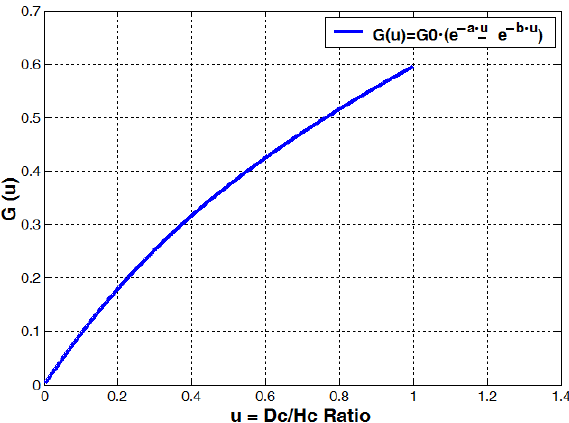
Figure 2. Coil geometry dimensionless function (factor) derived from the Lundin inductance formula and the Medhurst coil self-capacitance formula; here 𝜀 (cid:3040) = 1 .